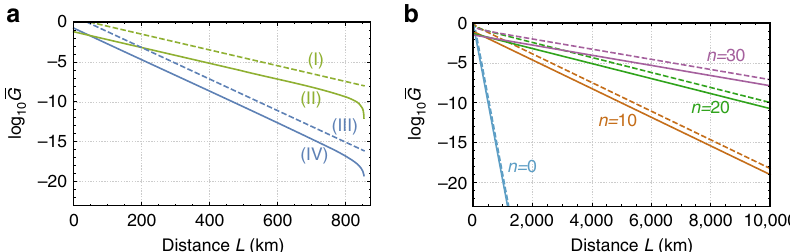
Figure 2 | Performance and upper bounds of protocols based on linear lossy optical channel networks. The performance is measured in terms of secret bits or ebits per average total channel use, (cid:2) G : ¼ log 2 d k = (cid:2) m l , for the distance L between Alice and Bob. As in Fig. 1b, the protocols use intermediate nodes h i k l l { C 1 , C 2 , y , C n } connected by optical fibres with transmittance Z l : ¼ e (cid:2) l = l att for attenuation length l att ¼ 22km with each other and located at regular intervals, say L 0 ¼ L /( n þ 1). The solid curves represent achievable performance, while the dashed curves are the upper bounds in equation (3) for the linear